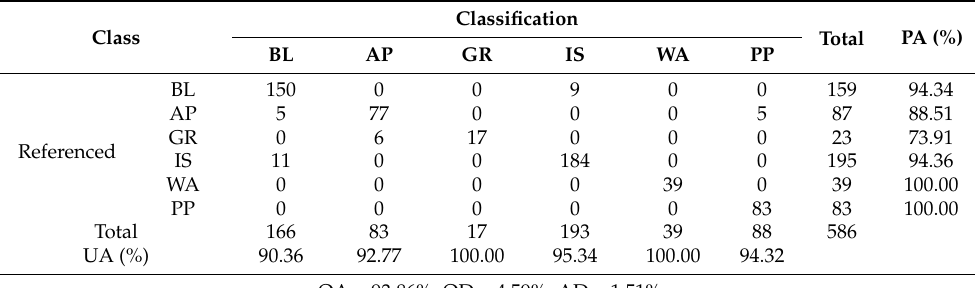
Table 3. Confusion matrix of final land cover map produced from the multi-temporal image. Class